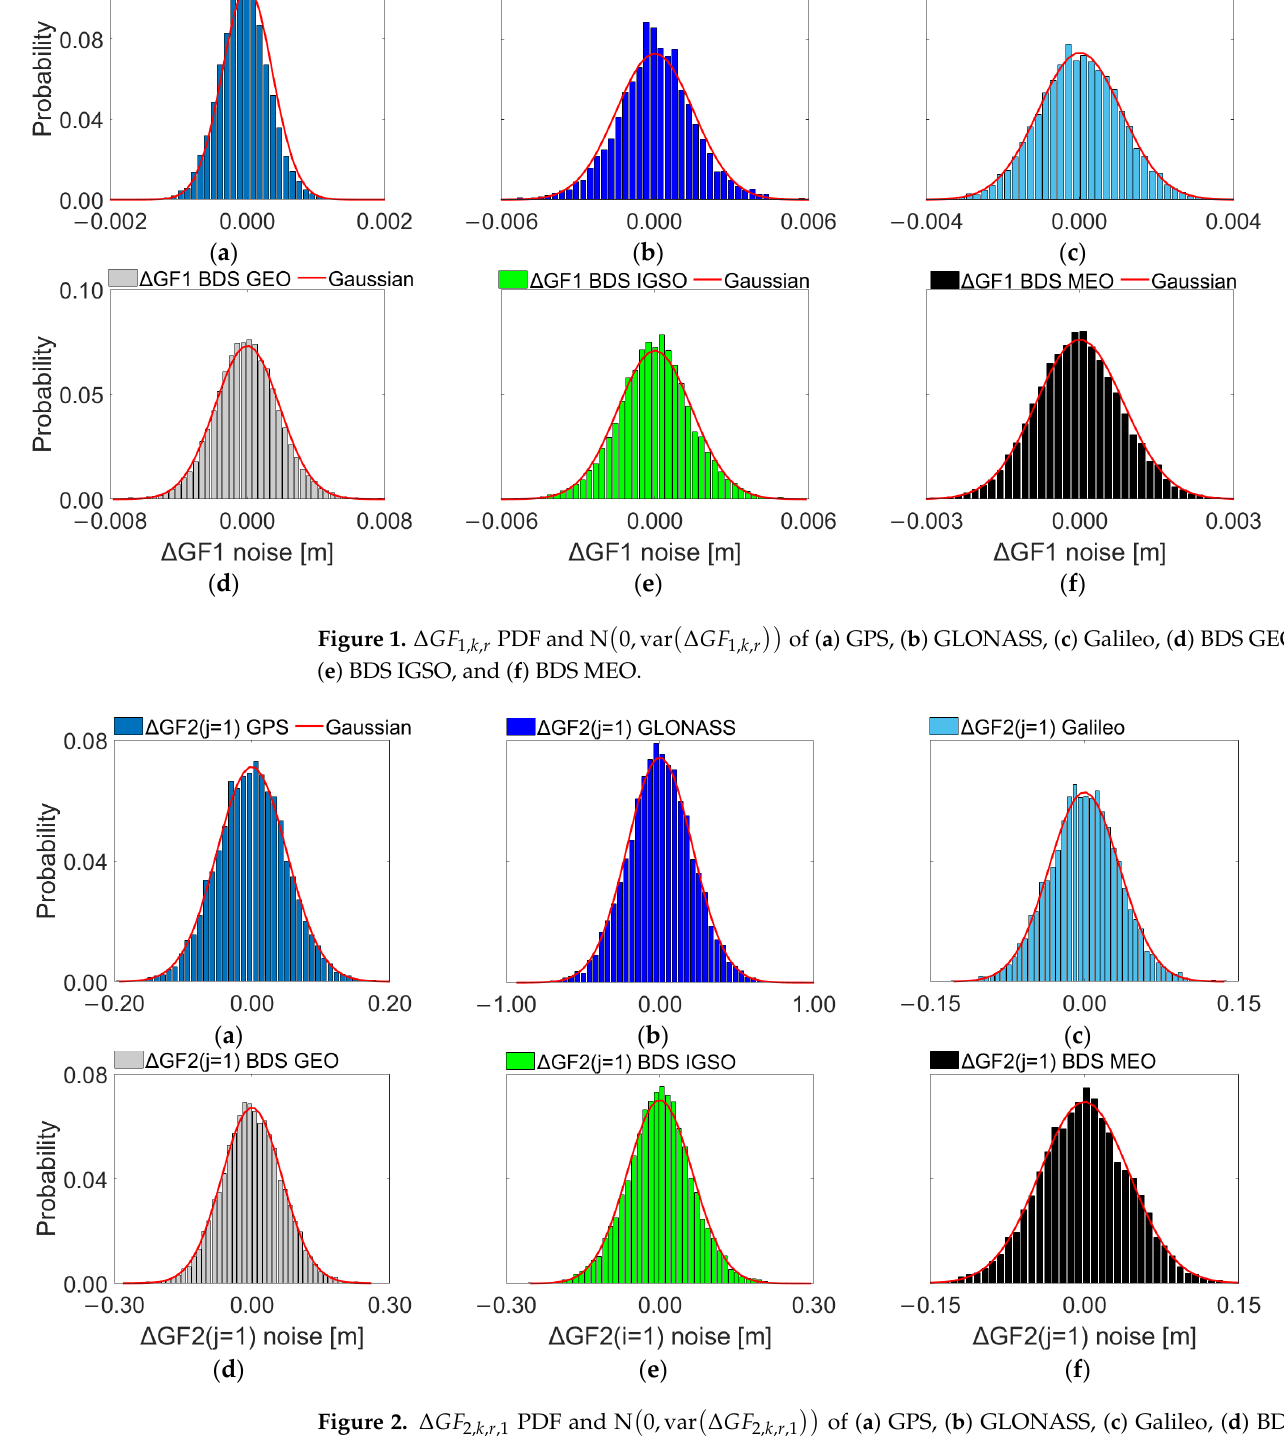
Figure 2. ∆𝐺𝐹 (cid:2870) , (cid:3038) , (cid:3045) , (cid:2869) PDF and N (cid:4672) 0, var (cid:3435)∆𝐺𝐹 (cid:2870) , (cid:3038) , (cid:3045) , (cid:2869) (cid:3439)(cid:4673) of ( a ) GPS, ( b ) GLONASS, ( c ) Galileo, ( d ) BDS Figure 2. ∆ GF 2, k , r ,1 PDF and N GEO, ( e ) BDS IGSO, and ( f ) BDS GEO, ( e ) BDS IGSO, and ( f ) BDS MEO.